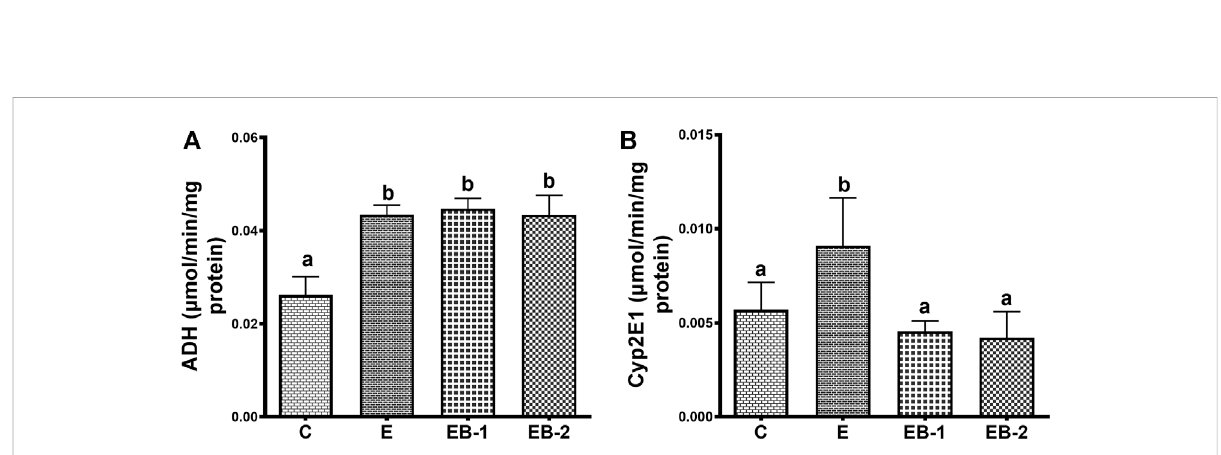
FIGURE 8 (A) Cytosolic ADH and (B) microsomal Cyp2E1 activity in the liver of mice gavaged with saline [C], ethanol [E], given betaine 2 h before [EB-1] or simultaneously with ethanol binges [EB-2]. Data are presented as mean values ± SEM ( n = 5); values not sharing a common letter signi fi cantly differ from each other at p ≤